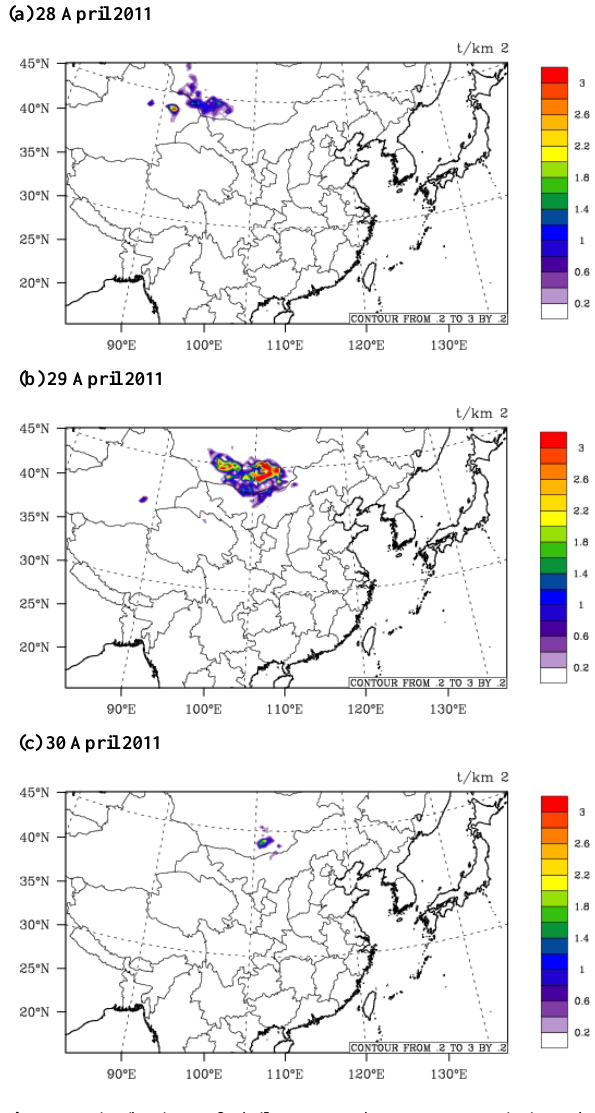
Fig. 4. Distribution of daily mean dust PM 10 emissions by DUST_REVISED Fig.4. Distribution of daily mean dust PM 10 emissions by DUST_REVISED model